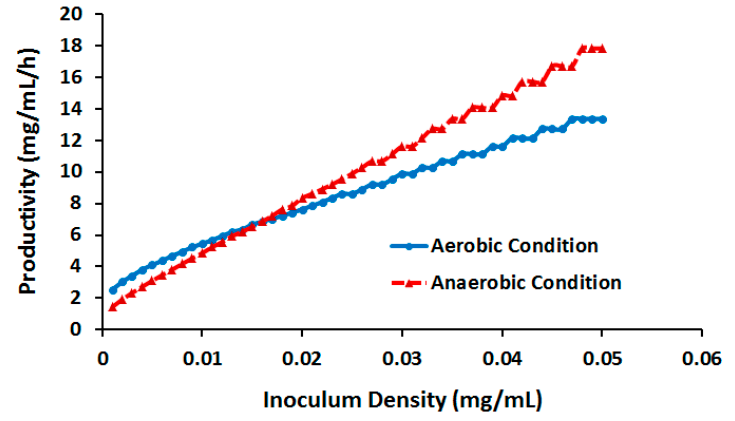
Figure 11. Productivity of TNT biotransformation vs. inoculum density.